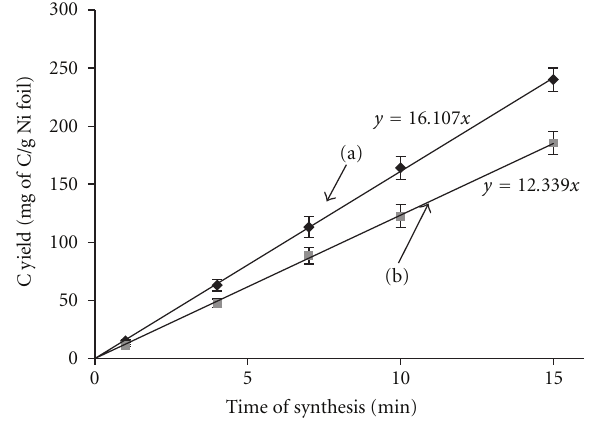
Figure 13: Yield of carbon versus time. (a) 815 ◦ C faceted foil; 2% C 2 H 2 , 20% NH 3 , 78% H 2 , and 570 ◦ C. (b) 715 ◦ C reduced foil; 2% C 2 H 2 , 98% H 2 , and 570 ◦